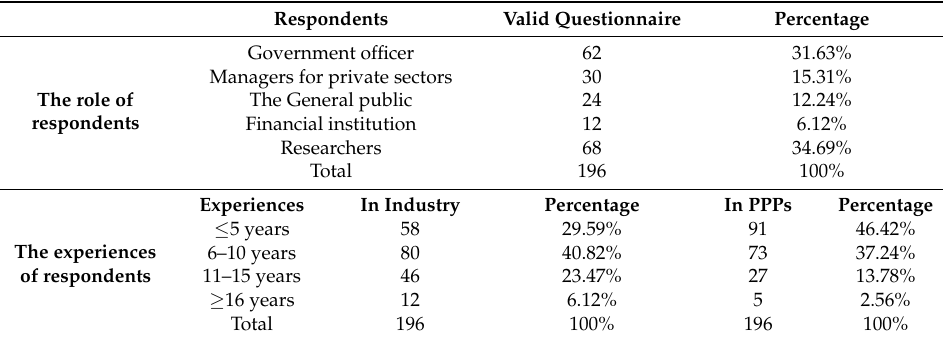
Table 1. Profile of the